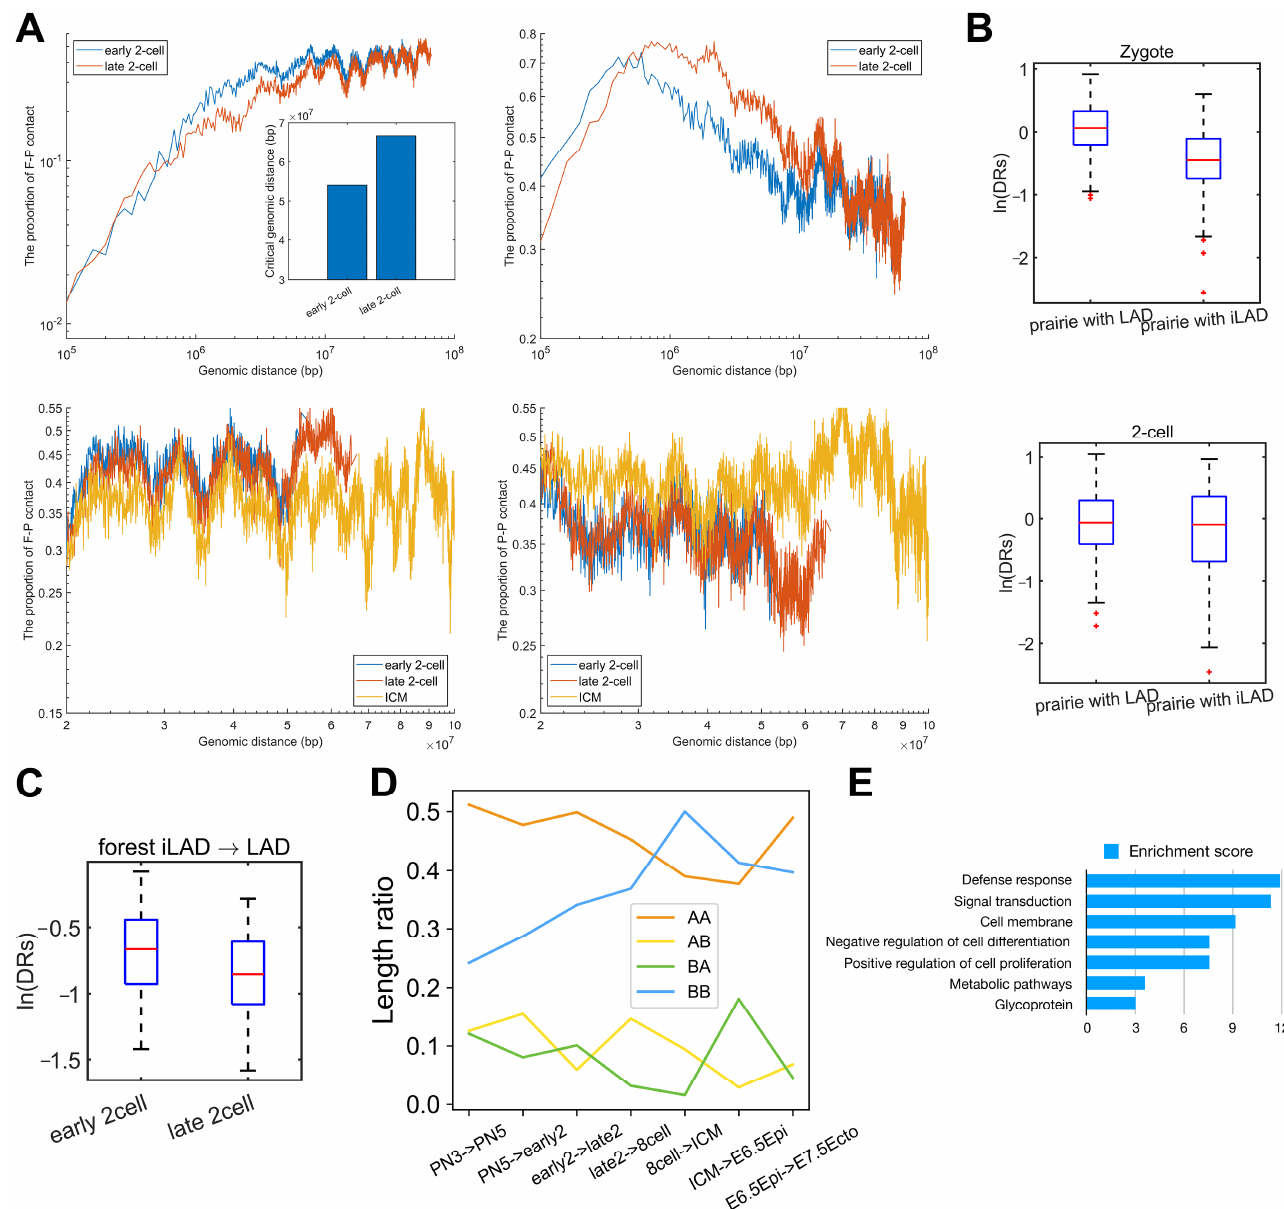
Figure 4. ZGA and associated 3D genome architecture change. ( A ) The upper two figures represent the proportion of F–P and P–P spatial interactions within the top 10% contact probabilities under one certain genomic distance, for normal mouse early 2-cell, late 2-cell. The lower two figures were the amplifications of the partial regions of two upper figures and ICM was also included for comparison. The inner plot represents the critical genomic distance of early 2-cell and late 2-cell. ( B ) The domain segregation ratio ( DR s ) of prairie domains that are/are not in LAD regions in mouse embryos. ( C ) The domain segregation ratio of forest domains switching from iLAD to LAD during mouse ZGA, in early 2-cell and late 2-cell. ( D ) The proportion of four components (AA: A → A, AB: A → B, BA: B → A, BB: B → B) in each transition of mouse embryos (e.g., from early 2-cell to late 2-cell). The length ratios of, e.g., AA for PN3 -> PN5 indicates the ratio between the genome length of stable A regions (between PN3 and PN5) and the entire genome length. ( E ) Function annotation clustering of prairie genes switching from B to A during mouse